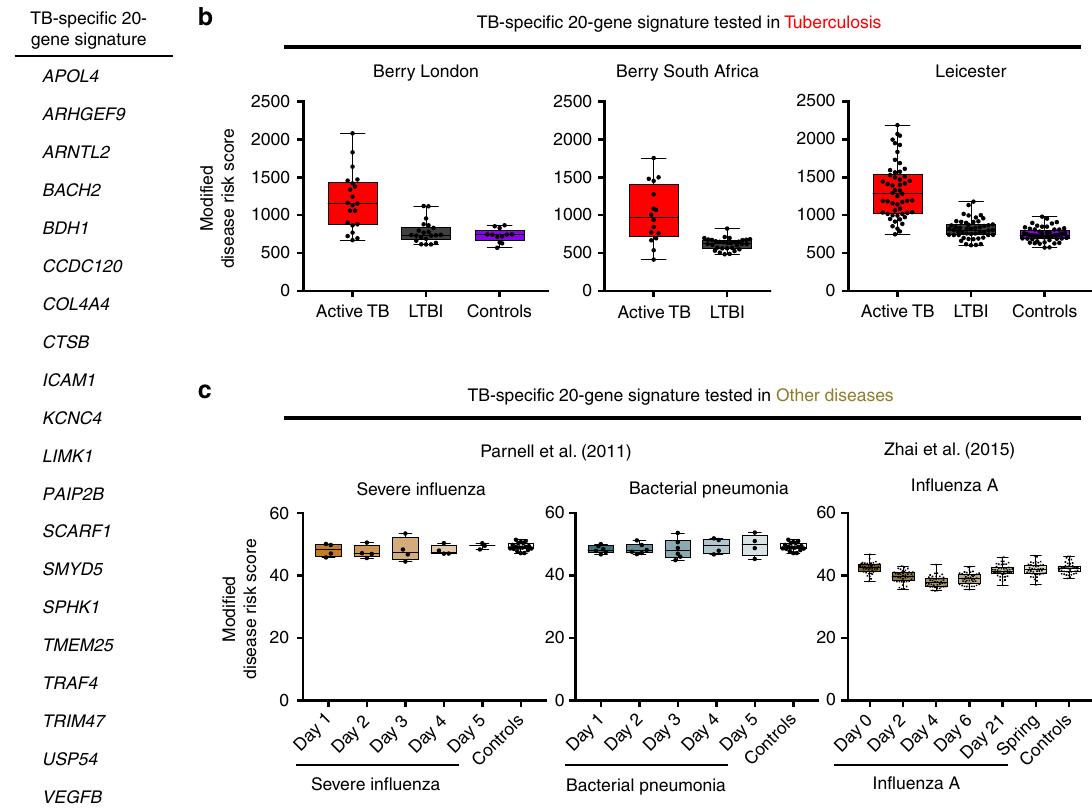
Fig. 6 Whole-blood TB-speci fi c 20-gene signature tested in TB and other infections. a A reduced 20-gene signature of TB derived from the TB-modular signature using genes signi fi cantly differentially expressed in Berry London cohort only and not in other fl u datasets (Supplementary Figure 6). b Box plots depicting the modi fi ed Disease Risk Scores derived using the TB-speci fi c 20-gene signature in TB datasets and in c datasets of other infections. The box represents 25th to 75th percentile, with a line inside the box indicating the median and the whiskers representing the minimum to the maximum points in the